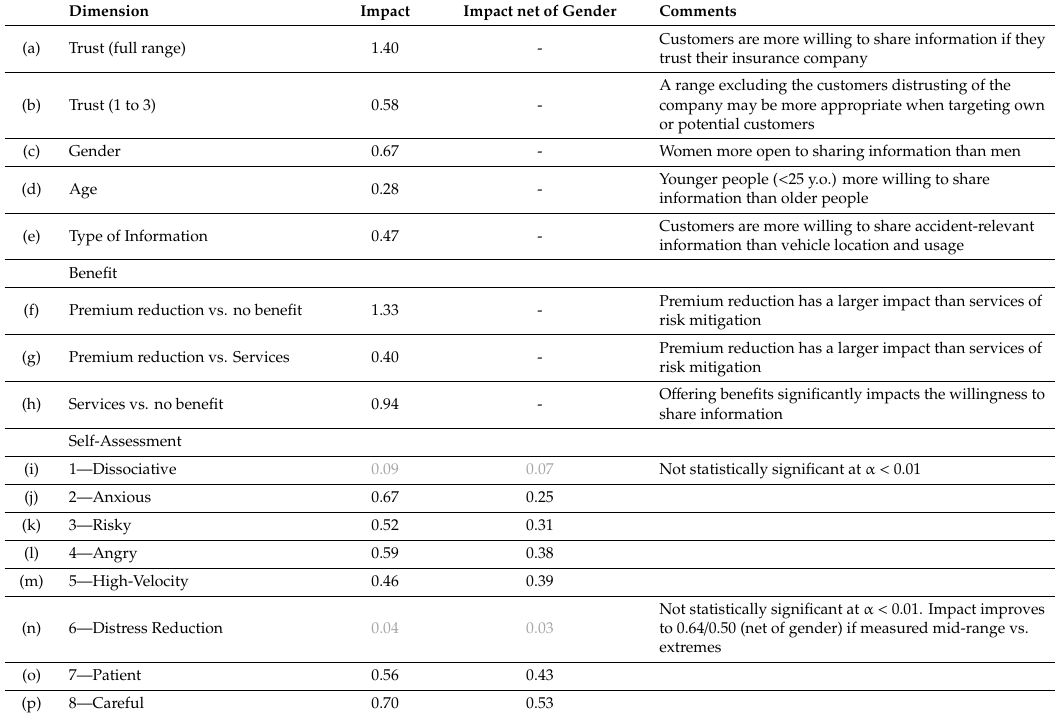
Table 13. Summary of the impacts on willingness to share personal information. Figures in grey are not statistically